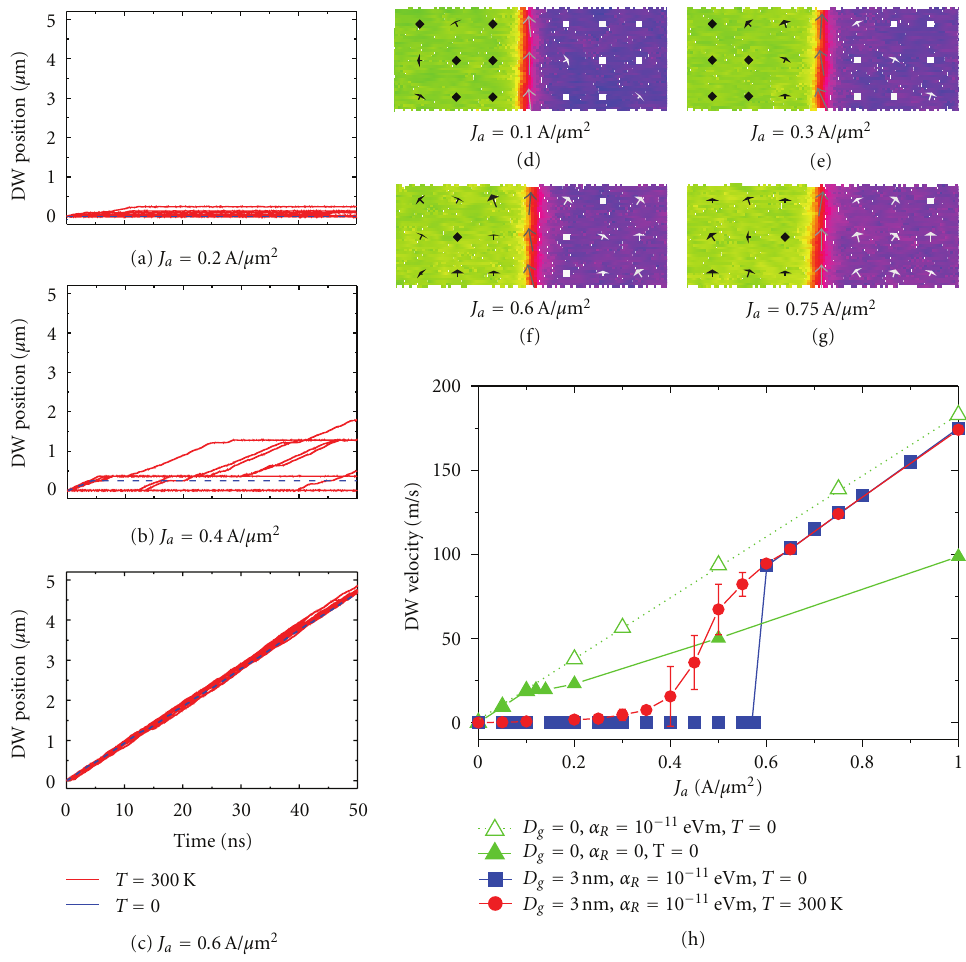
Figure 5: (a)–(c) x ( t ) versus t along a rough strip ( D g = 3nm) for di ff erent j a with α R = 10 − 11 eVm at zero (blue-dashed lines) and at room temperature (red-solid lines). (d)–(g) Typical DW configurations under di ff erent j a . (h) DW velocity as a function of j a . (Reprinted with permission From [71]. Copyright (2012), American Institute of